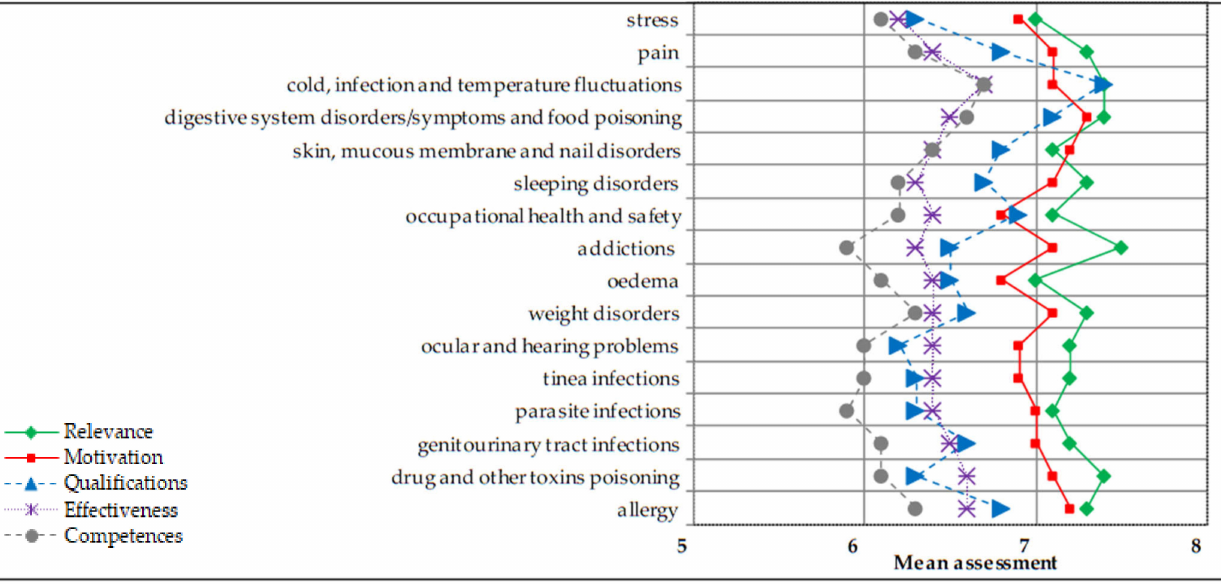
Figure 3. Pharmacy students’ mean assessment of qualifications, competences, relevance, motivation and effectiveness in health promotion— items in coping with health problems (N = 206). Scale 1–10 where: 1—very low, 10—very